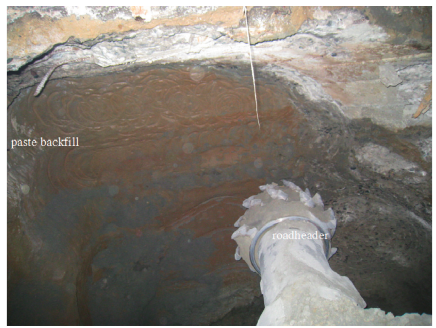
Figure 7: Excavating tunnel in paste